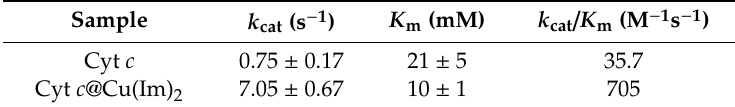
Figure 4. ( a ) The kinetic analysis of free Cyt c and Cyt c @Cu(Im) 2 , the chromogenic reaction of free Cyt c ( insert A ) and Cyt c @Cu(Im) 2 ( insert B ) ; ( b ) The activity of (1) free Cyt c , (2) Cyt c /copper ion. (3) Table 2. Kinetic parameters for free enzyme Cyt c , and Cyt c @Cu(Im) 2 . Table 2. Kinetic parameters for free enzyme Cyt c , and Cyt c @Cu(Im) 2 . Cyt c /Cu(Im) 2 , (4) Cyt c /Im and (5) Cyt c @Cu(Im) 2 , respectively. Sample